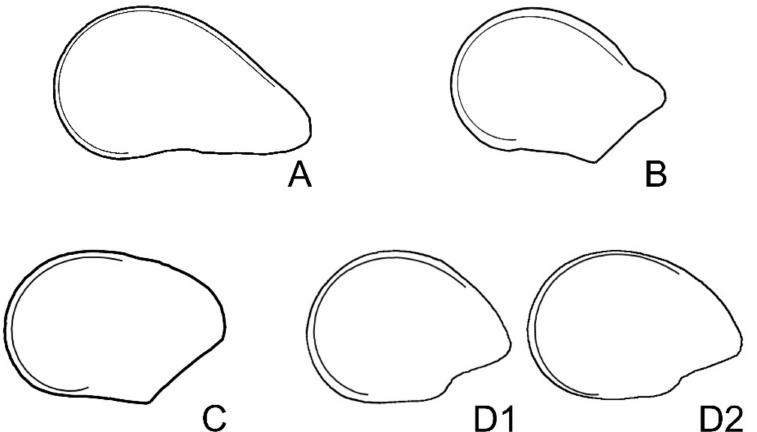
Figure 4. ( A ) Model HYLO1, designed for Hylocereus undatus seeds, with the curve corresponding to the equation r = t − 1 3 with t ∈ [ 0.3, 5 ] superimposed. ( B ) Model PACHY1, designed for Pachycereus pringlei seeds with the curve corresponding to the representation of equation r = t − 1 3 with t ∈ [ 0.5, 5 ] superimposed. ( C ) Model FERO1, designed for Ferocactus herrerae , and ( D1 , D2 ), Models ECHI1 and ECHI2, for Echinocactus platyacanthus , with the representation of equation r = t − 1 3 with t ∈ [ 1, 5 ] . The complementary parts of the models (not represented in the curves) are obtained from the average silhouettes for each species in Corel Photo